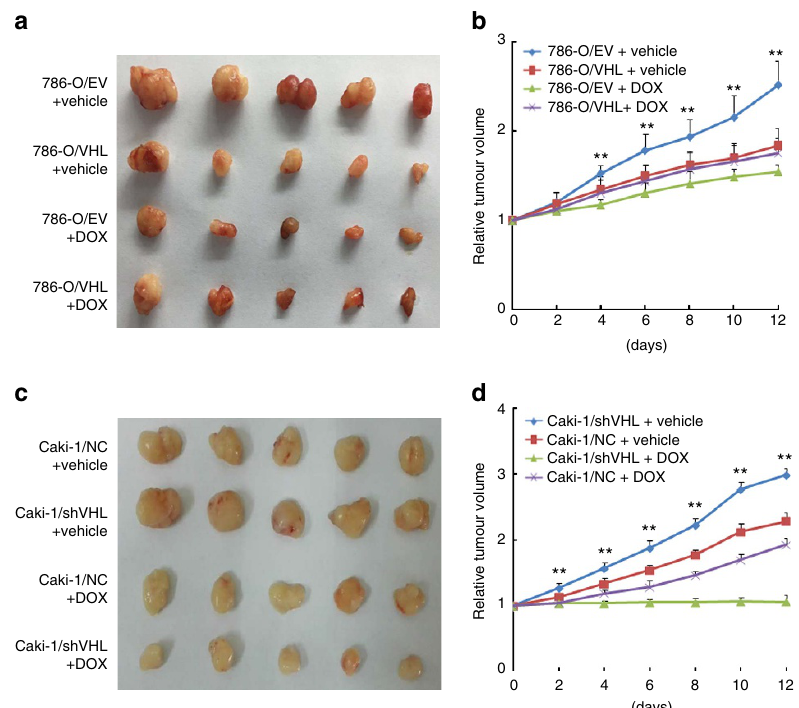
Figure 2 | VHL-deficiency augments the sensitivity of ccRCC cells to anthracyclines in vivo . All indicated cells (5 (cid:3) 10 6 ) were injected into NOD/SCID mice. Tumour-bearing mice were treated every two days with vehicle or with 4mg per kg doxorubicin by intraperitoneal injection. Five tumours per condition were analysed. ( a , c ) Pictures of tumour in NOD/SCID mice injected with the indicated cells. ( b , d ) Relative tumour volume growth. Data are mean ± s.d. ( n ¼ 5 for each group). (* P o 0.05, ** P o 0.01 for t